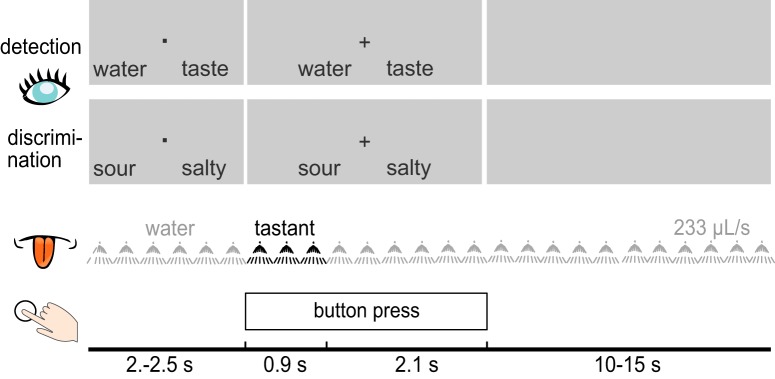

Schematic illustration of the experimental design during the detection and discrimination tasks. The first two rows portray examples of visual cues displayed to participants during detection and discrimination trials. During each trial, a liquid tastant (black) was embedded in a sequence of water pulses. Participants were to speededly respond by button press during both tasks.